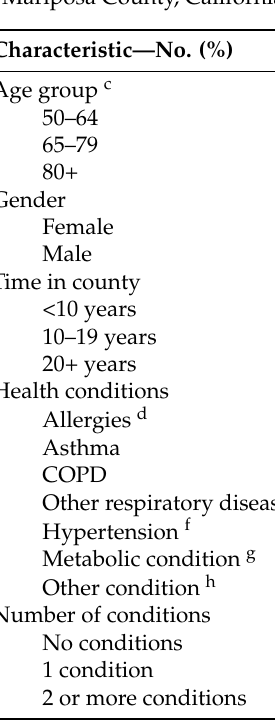
Table 1. Characteristics of survey participants in a medically vulnerable adult population (N = 106) a in Mariposa County, California, 2021 b